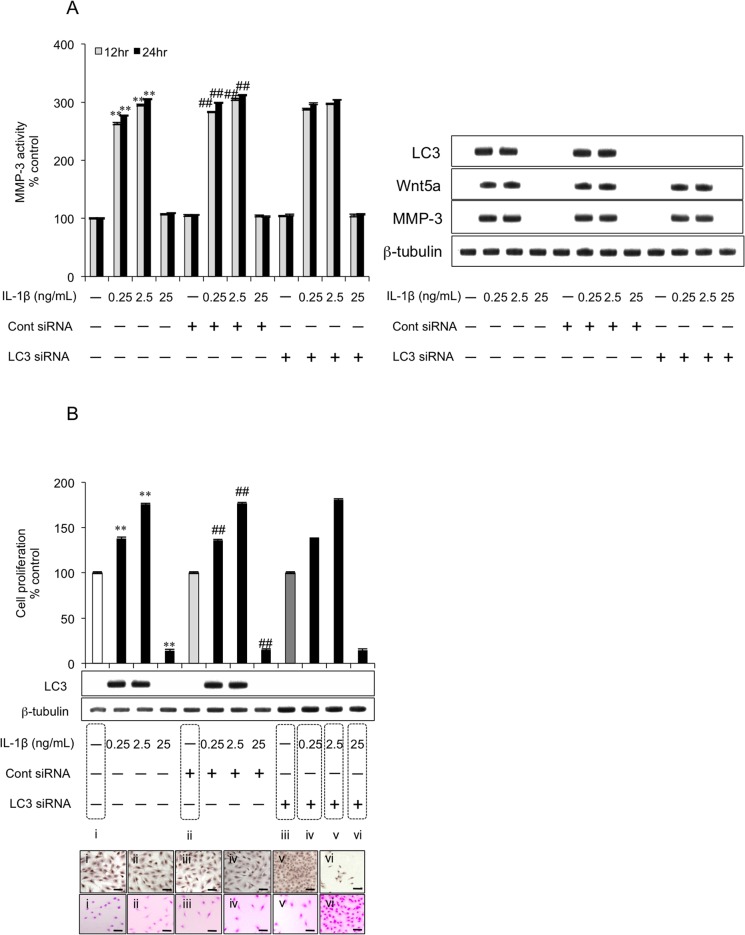
Effect of LC3 siRNA on IL-1β-induced MMP-3 activity and cell proliferation.(A) E14Tg2a ES cell-derived odontoblast-like cells were transfected with LC3 siRNA for 24 h and treated with IL-1β (0, 0.25, 2.5 and 25 ng/mL) for either 12 h (grey bars) or 24 h (black bars), prior to carrying out an MMP-3 activity assay (left) and western blotting for LC3, Wnt5a and MMP-3 (right). (B) Results of the BrdU-cell proliferation ELISA (for cell proliferation; graphs), BrdU Immunohistochemistry Kit (for cell proliferation; images, upper row), and APOPercentage Apoptosis Assay Kit (for apoptosis; images, lower row) are shown. β-tubulin was used as a housekeeping protein in western blots. **P < 0.01 vs. control; ##
P < 0.01 vs. control siRNA; †
P < 0.01, as indicated by the bracket. The BrdU ELISA kit stains the nuclei of proliferating cells dark brown. Accumulation of dye (pink-purple) denotes apoptosis in the APOPercentage kit. Images are representative of at least three independent experiments. Scale bars = 100 μm.